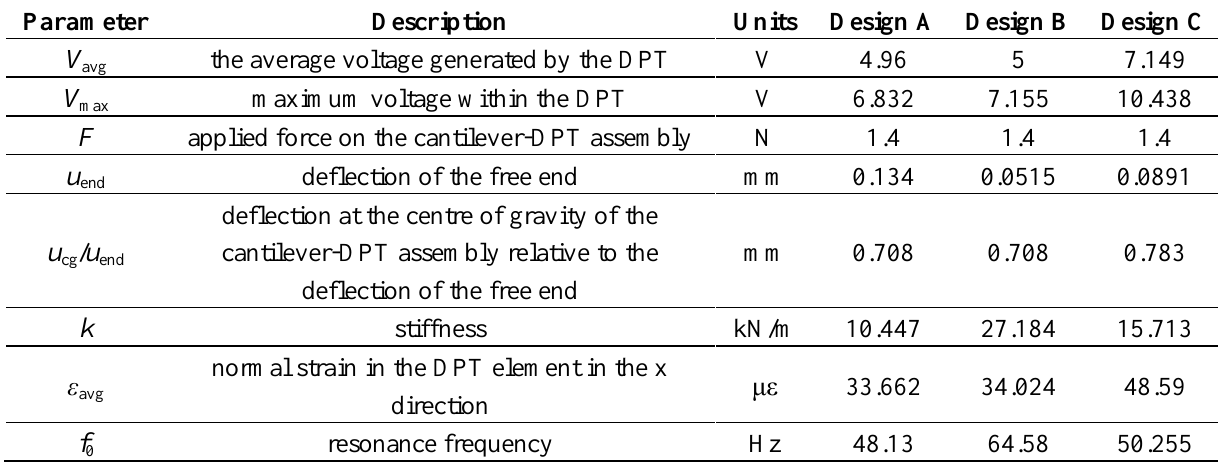
Table 4. Summary of the FEA simulation results.